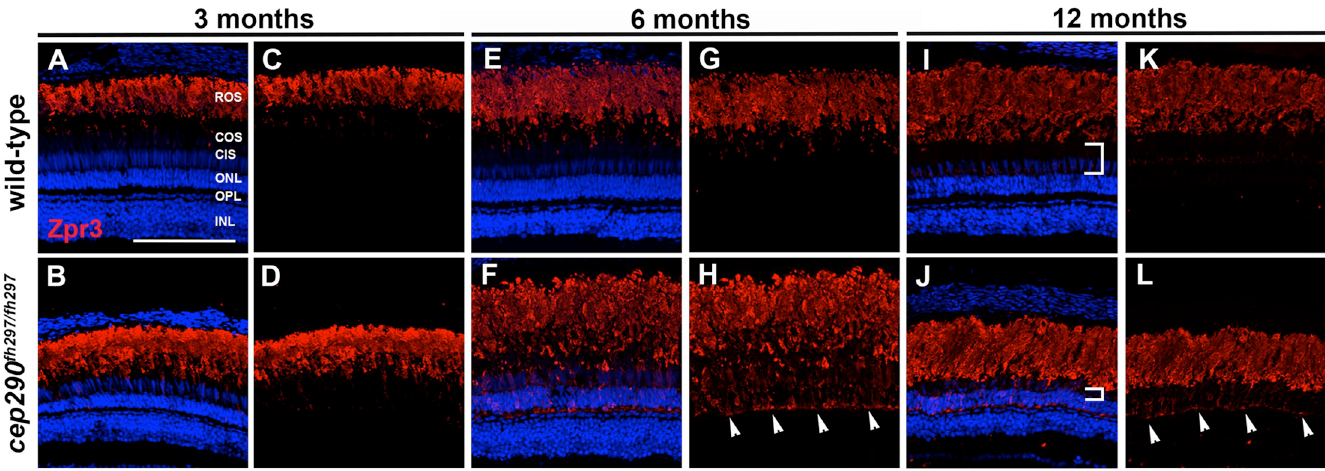
Fig 6. Mislocalization of rhodopsin in cep290 fh297/fh297 mutants. (A-D) Images show cryosections labeled with Zpr3 (red) to mark rhodopsin and DAPI (blue) to label nuclei in the dorsal retinas from cep290 fh297/fh297 mutants and wild-type siblings at 3 months of age; (E-H) 6 months of age, and (I-L) 12 months of age. At later ages, the distance between the base of the rod outer segments and the outer nuclear layer decreases due to loss of cone nuclei (I, J; white brackets). Arrowheads note rhodopsin mislocalization. ROS, rod outer segments; COS, cone outer segments; CIS, cone inner segments; ONL, outer nuclear layer; OPL, outer plexiform layer; INL, inner nuclear layer. Scale bar: 100 μ